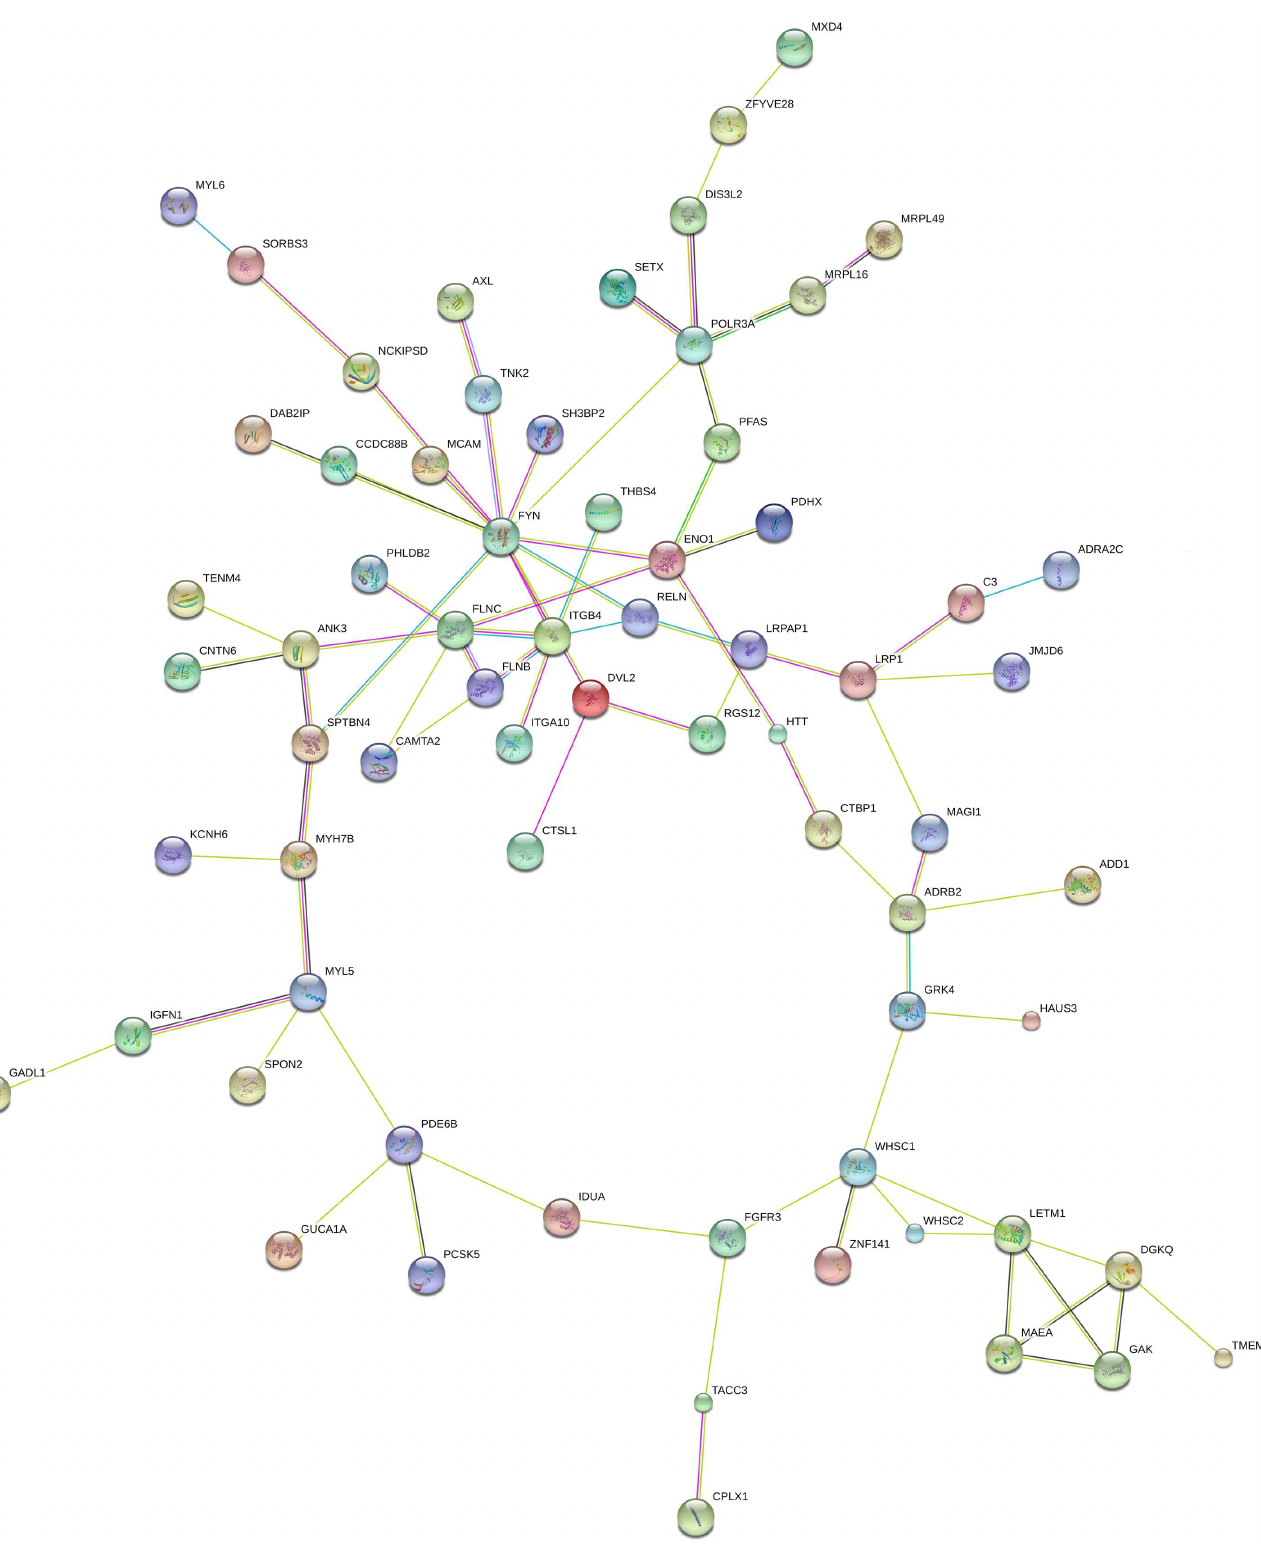
PLOS ONE | DOI:10.1371/journal.pone.0170386 January24,